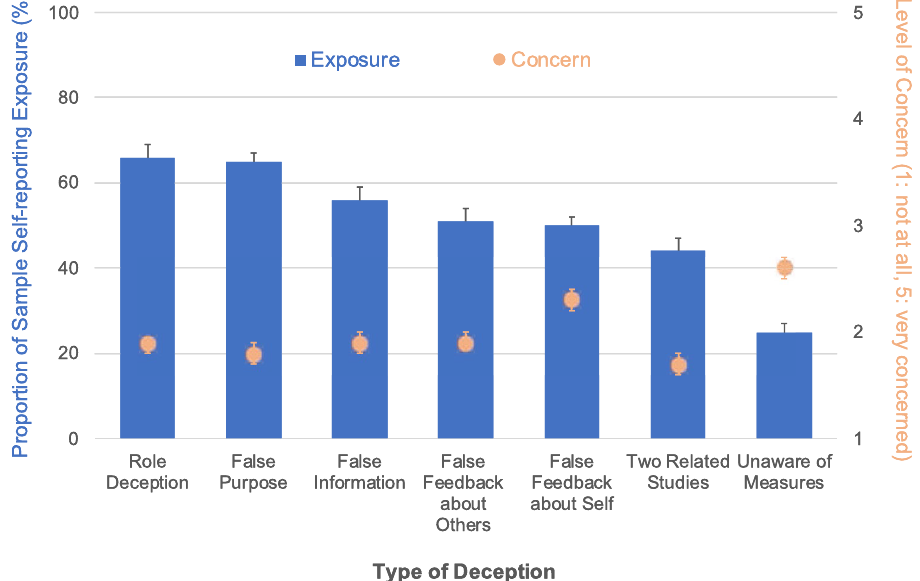
Figure 2. Participant past exposure to different types of deception and respective levels of concern (Study 2, n = 1,209). Role deception and false purpose are the most common types of deception participants report having been exposed to in prior experiments; being unaware of measures is the least common form. Level of concern is generally low across deception types, with the least concern being expressed for false-purpose deception and studies that present two related studies as being unrelated, and the highest concern for receiving false feedback about oneself and being unaware of measures in the experiment (e.g., filming, eye-tracking). Bars and spots reflect means; the error bars are 95% confidence